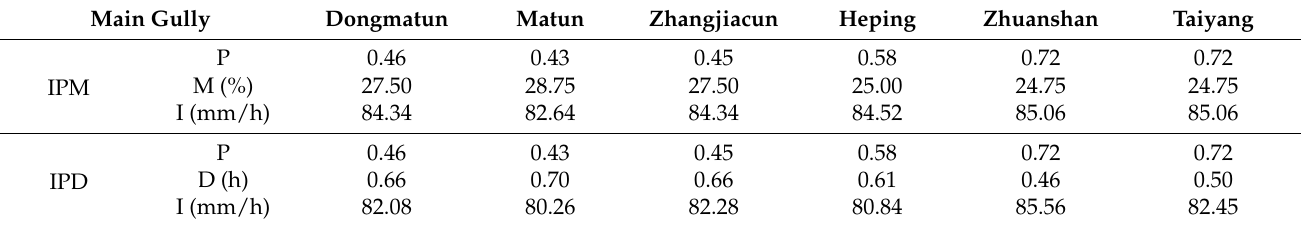
Table 7. Critical rainfall prediction results of IPM and IPD models in a debris flow gully in the Laomao Mountain area. Main Gully Dongmatun